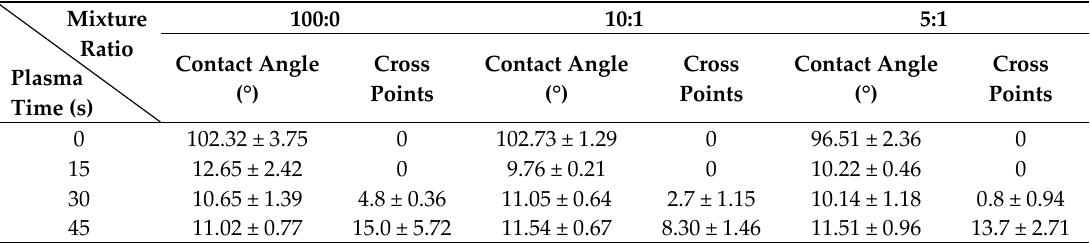
Figure 2. Electrical and mechanical properties of mixture of Ecoflex and polydimethylsiloxane (PDMS) varied by O 2 plasma treatment time. ( A )–( C ) Optical images of contact angle (left) and surface crack of elastomer (right). The substrate mixture ratio is ( A ) Ecoflex:PDMS = 100:0, ( B ) Ecoflex:PDMS = 10:1, and ( C ) Ecoflex:PDMS = 5:1. ( D ) The current–voltage curve of deposited CNT on the substrate (Ecoflex:PDMS = 5:1), ( E ) by stretching the double-layered substrate to 100% strain, the mechanical stress of three di ff erent types of substrate changed in kN / m 2 . Table 1. The number of the cross points in the crack lines and mean value and standard deviation for contact angles of water drop on various substrates, according to the treatment time of O 2 plasma.